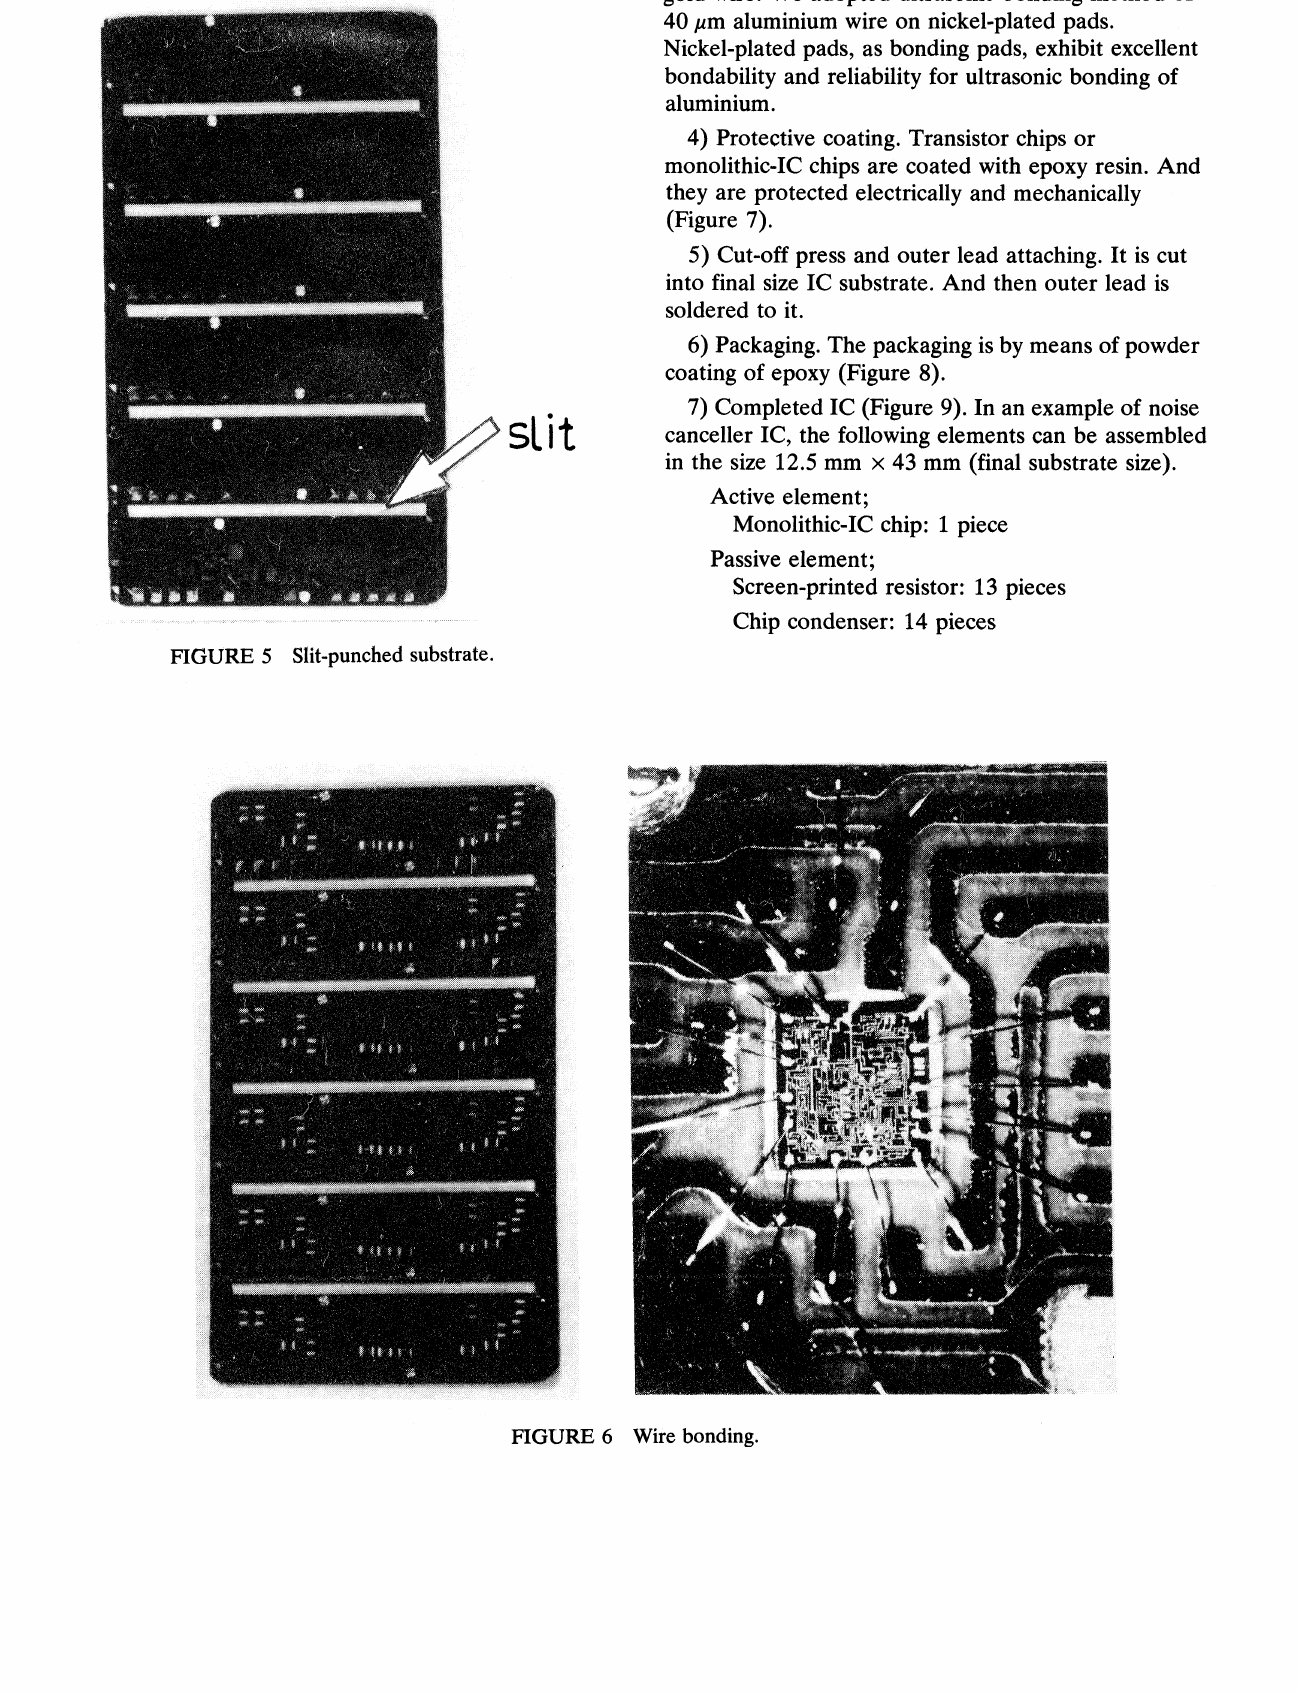
FIGURE 5 Slit-punched substrate.